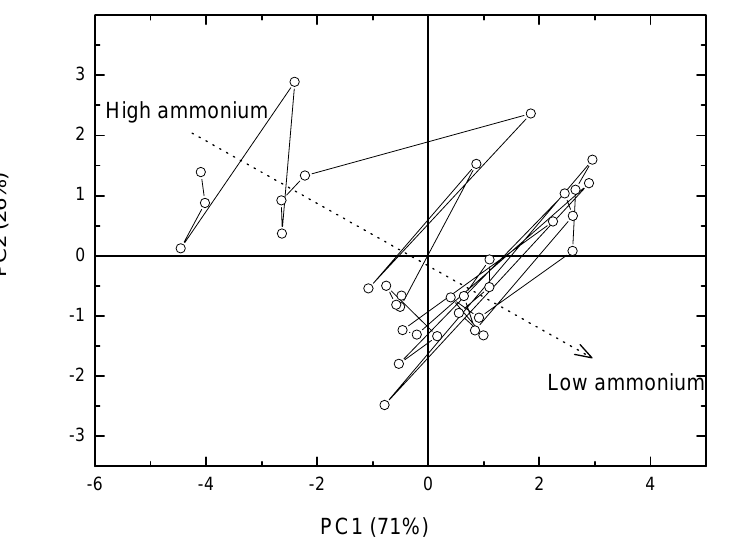
Figure 2. PCA score plot of 34 samples in test mixtures of key odorants containing ammonium at pH 6. Concentration of n-butyrate was below 10 -4 M. Full cross validation was used and six electrodes were sufficient.